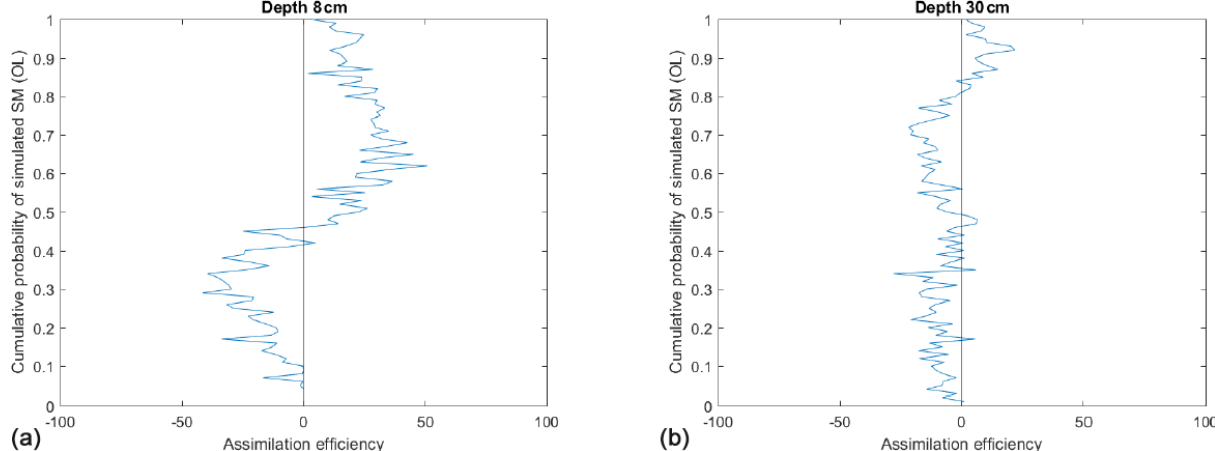
Figure 9. Assimilation efficiency as a function of simulated soil moisture quantiles, namely the upper soil layer (a) and deeper soil layer (b) .